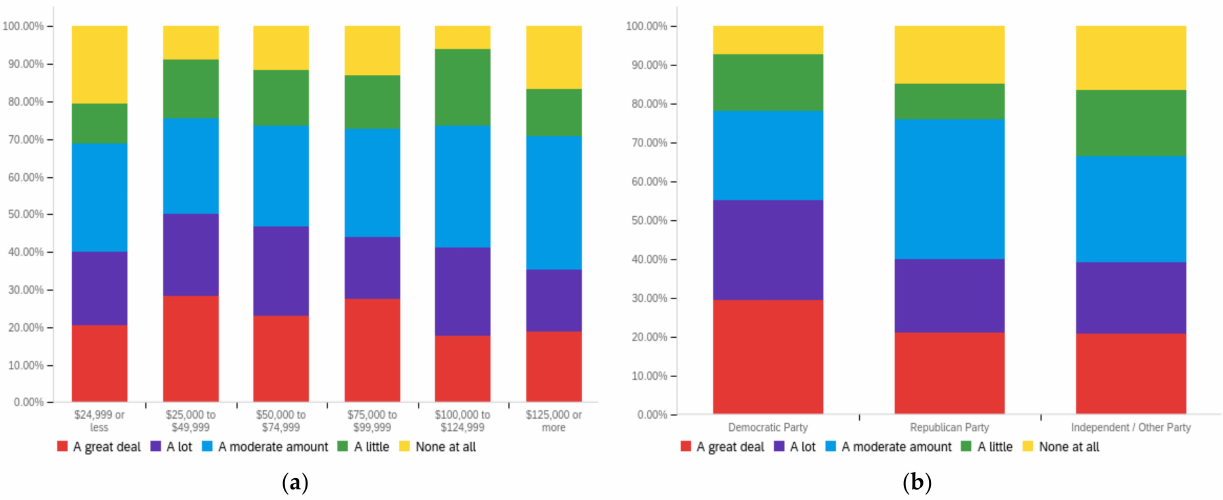
Figure A13. Cont